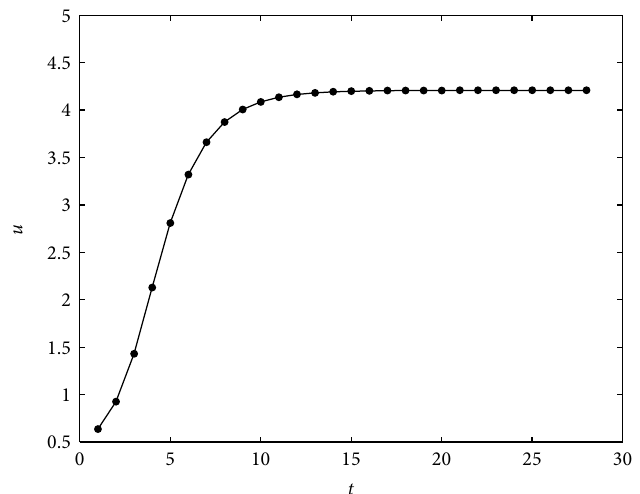
Figure 2: Stable stationary state of the discrete model when conditions in Eq. (10a) are satisfied